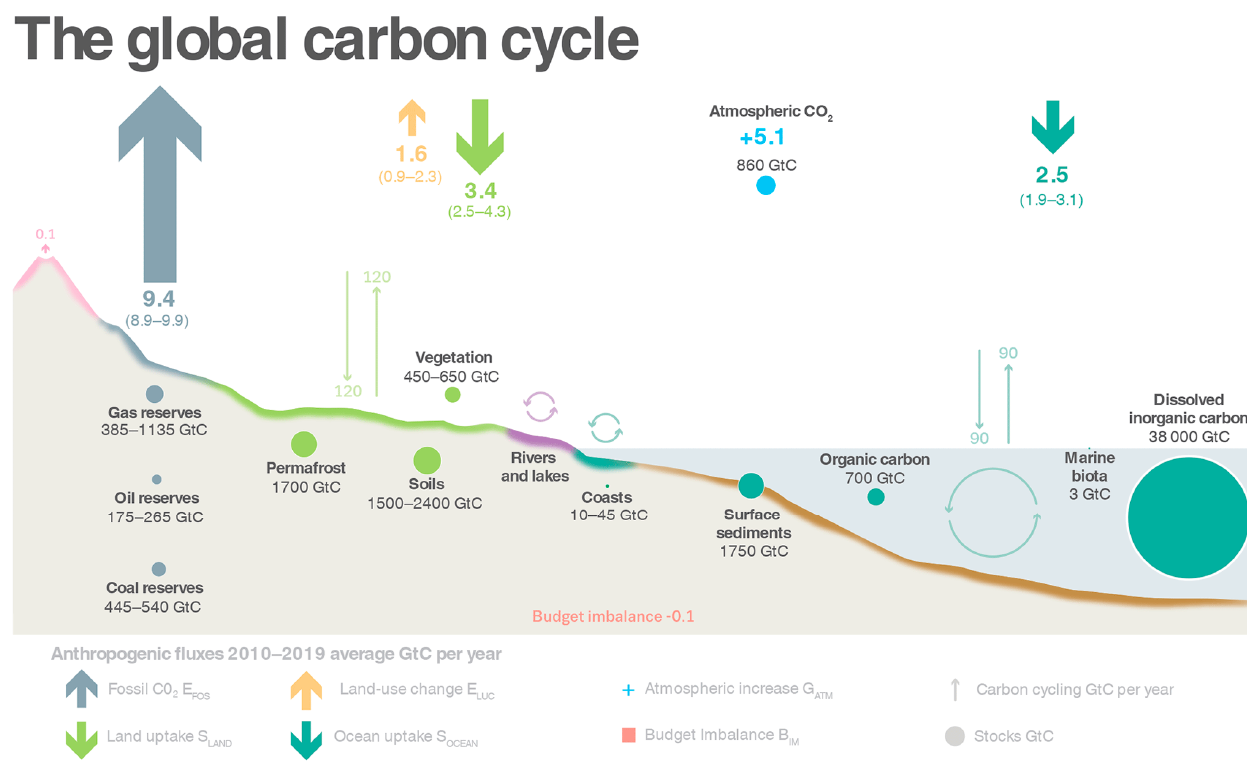
Figure 8. Anthropogenic emissions—CO 2 emissions from fossil fuels, Earth System Science Data [20].